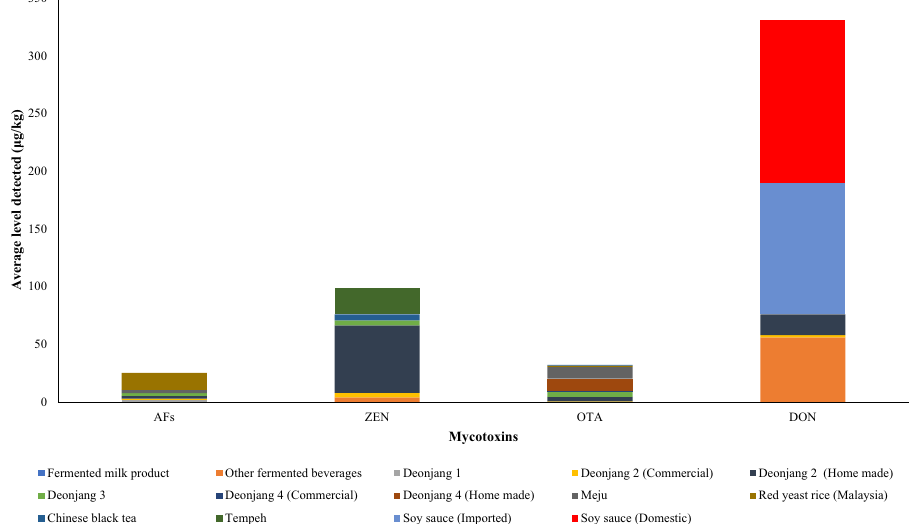
Fig. 3 Maximum mycotoxin concentrations detected in Asian ffs. AFs A fl atoxins, ZEN Zearalenone, OTA Ochratoxin A, DON Deoxynivalenol. *Deonjang 1 – 4 indicated samples analyzed by different